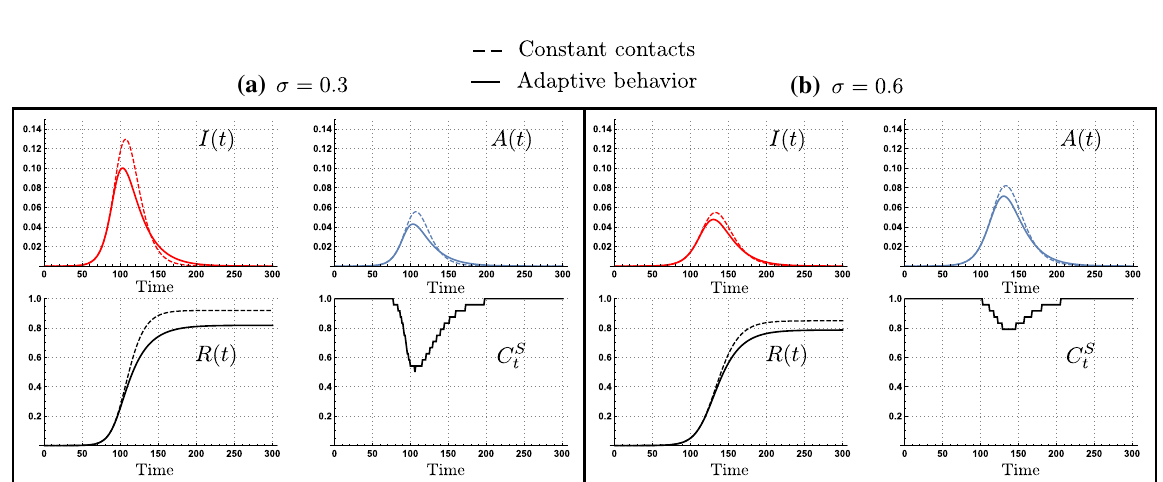
Figure 1. Disease dynamics under adaptive behavior (thick curves) and constant contact rates (dashed curves). The scenarios where 30% ( a ) and 60% ( b ) of cases become asymptomatic show differential S behavioral response ( C t ) as a function of the risk perception, impacting the attack rate. Parameters τ = 14, ν = 0.1, ǫ = 0.4, C I = max C t , l = 1 and ρ = 0.25